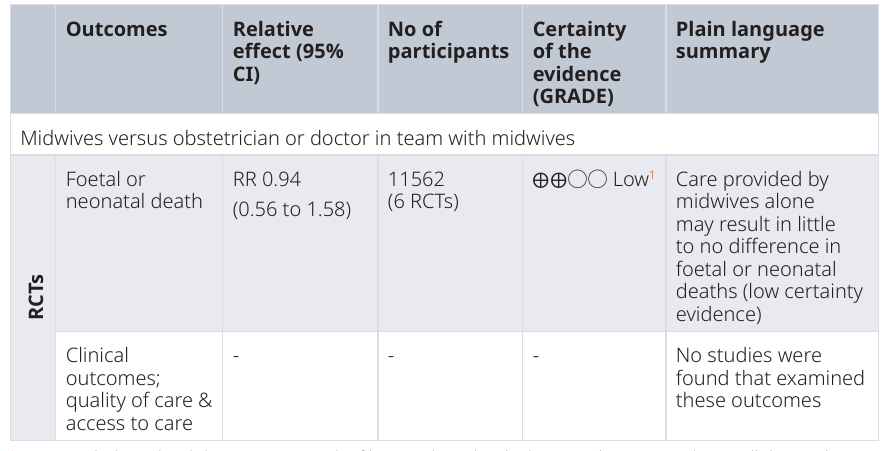
Table 2. Summary of findings for care provided by MLHPs for neonatal and infant health care